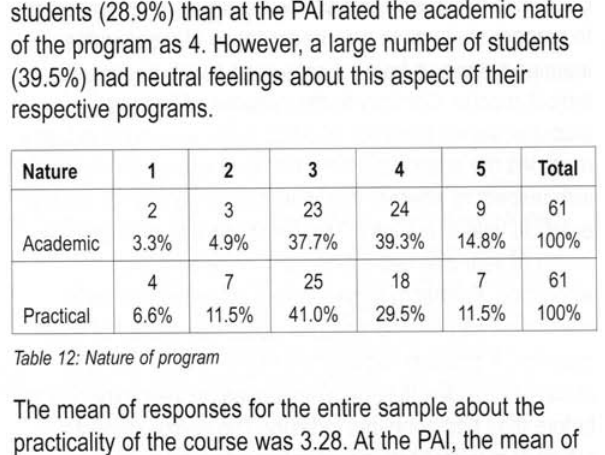
Table 12: Nature of program The mean of responses for the entire sample about the practicality of the course was 3.28.At the PAl, the mean of responses was 3.46. A large proportion of the students (45.8%) rated the practicality of the program 4. However, many students (41 .7%) had neutral feelings about this aspect of the program. At the HOI, the mean of responses was 3.16. A much smaller proportion of the students (18.9%) than at the PAl rated the practicality of the program 4. However, a similar proportion of students (40.5%) had